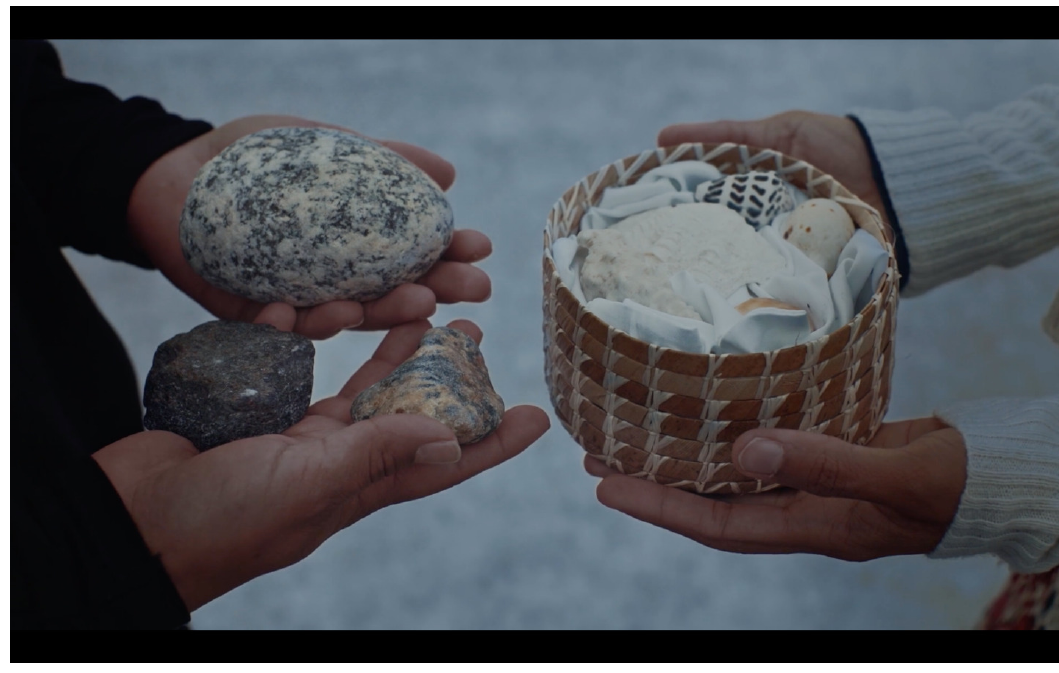
Figure 3: Rise: From One Island to Another . Source: Image courtesy of the